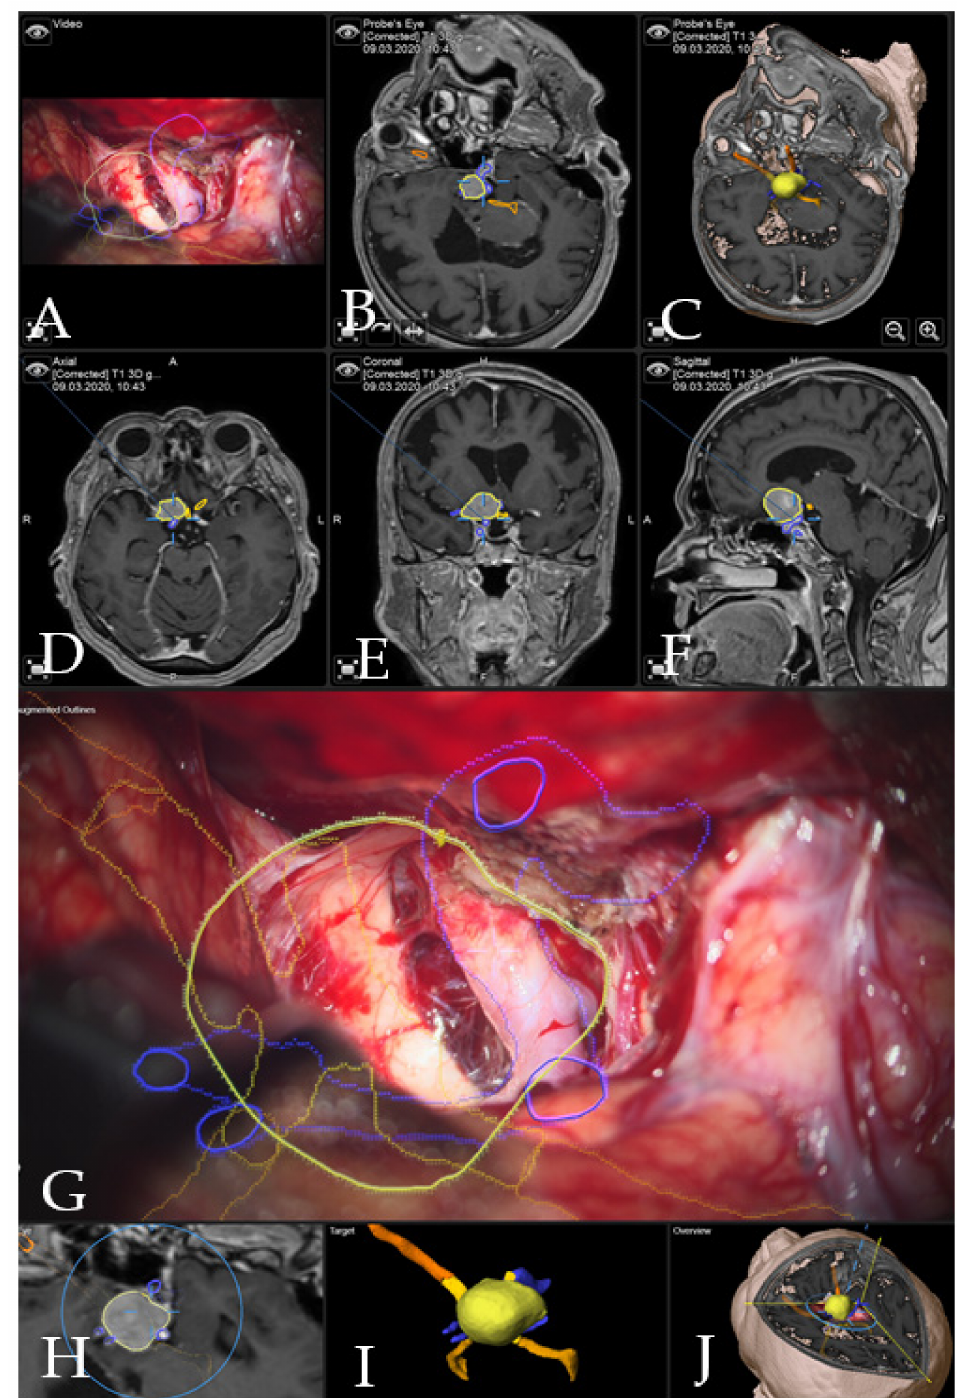
Figure 4. Navigation and AR support following complete resection of the tumor (patient no. 20). ( A ) Microscope video with head-up display and 3-dimensional (3D) visualization of the segmented objects (tumor in yellow, carotid and anterior cerebral arteries in blue, optic chiasm in yellow). ( B , C ) Probe’s eye view in 2-dimensional and 3D fashion. ( D ) Axial, ( E ) coronal and ( F ) sagittal views of standard navigation display with the segmented objects (focus on the sellar floor following complete resection). ( G ) AR display on video screen with the 3D outline of segmented structures. ( H ) Corresponding probe’s eye view. ( I ) Target view and ( J ) overview depicting the video plane in relation to the segmented 3D